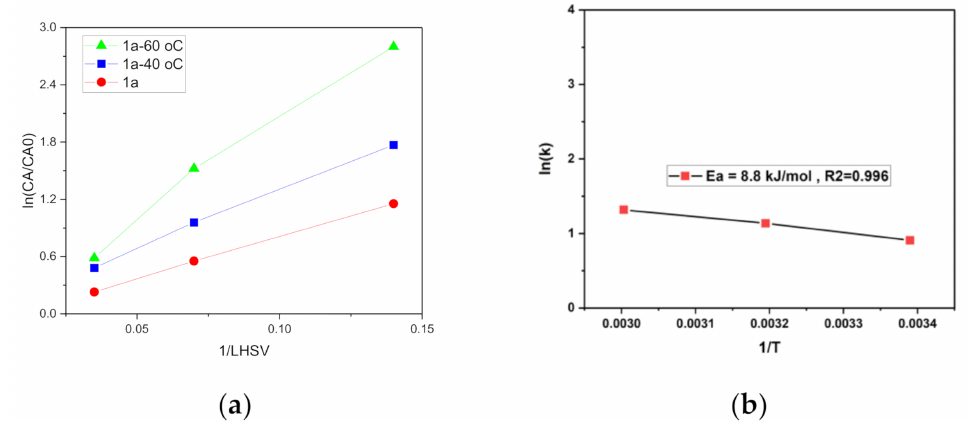
Figure 4. Arrhenius plot of catalyst 1a loaded in reactor 1 , which followed first-order reaction